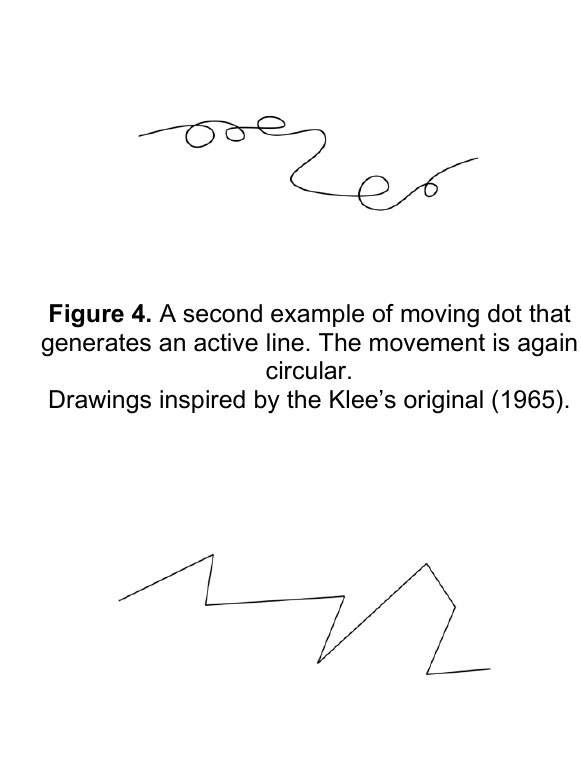
Figure 5. A third example of a moving dot that generates an active line. In this case, the movement is piece-wise straight. Drawings inspired by the Klee’s original